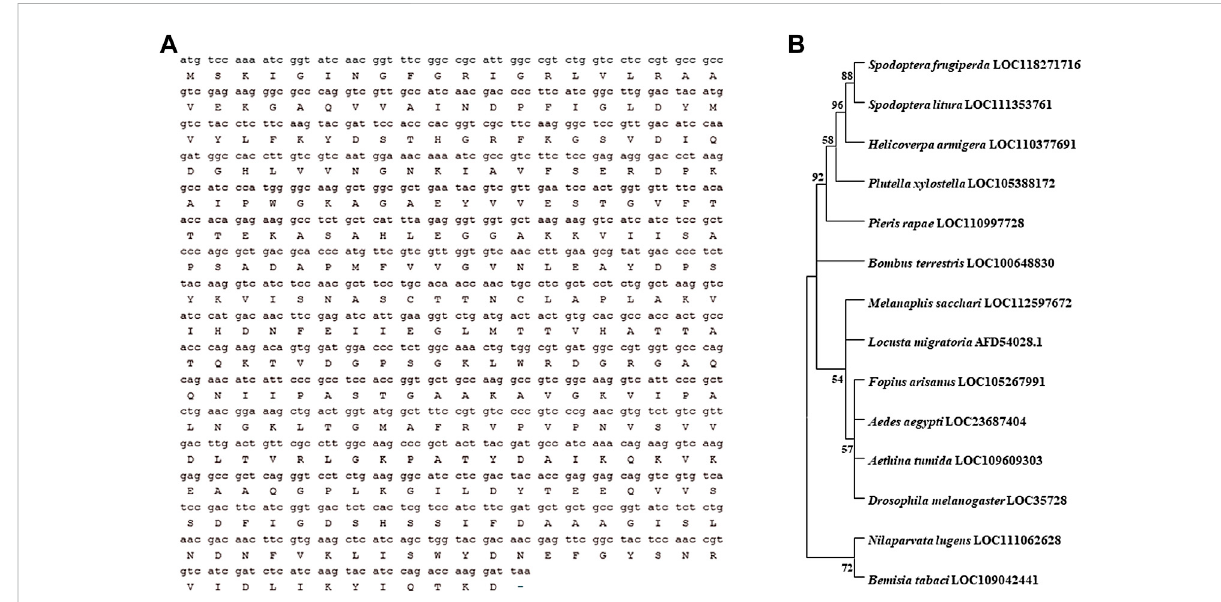
FIGURE 1 Bioinformaticanalysisofthe HaGAPDH sequence. (A) ORFsequence andtheamino acidsequence of HaGAPDH . (B) Phylogenetic tree analysis of GAPDH. The tree was constructed by MEGA 11.0